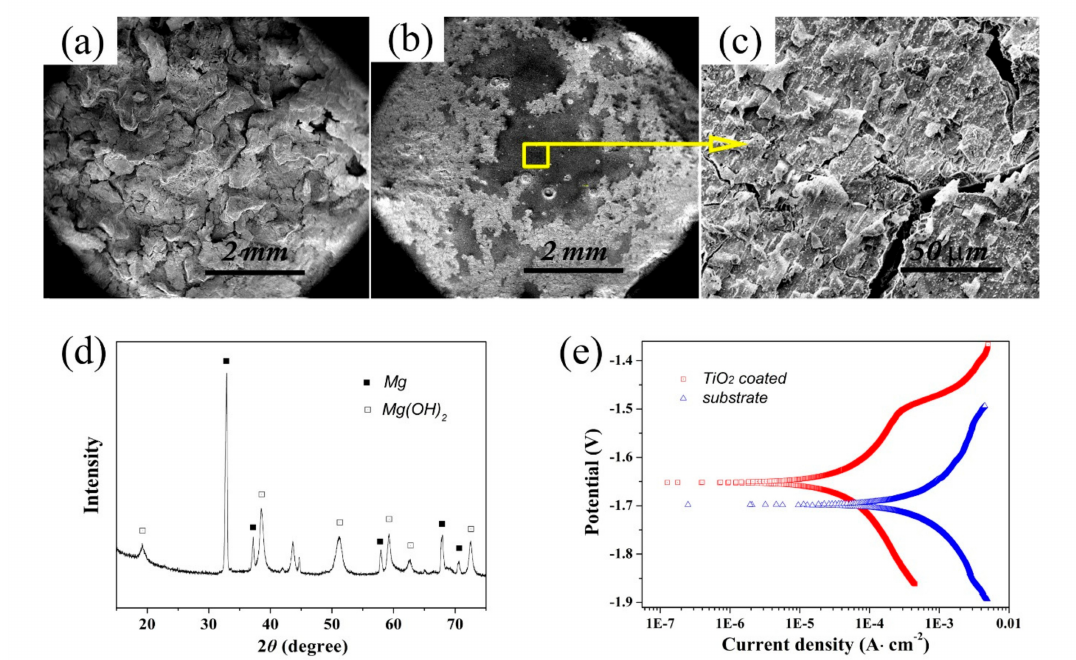
Figure 4. SEM images of ( a ) bare and ( b , c ) TiO 2 -coated MgZn samples after 14 d immersion in simulated body fluids (SBFs); ( d ) XRD pattern of corrosion products and ( e ) potentiodynamic polarization curves in SBF of samples (tested after the coating